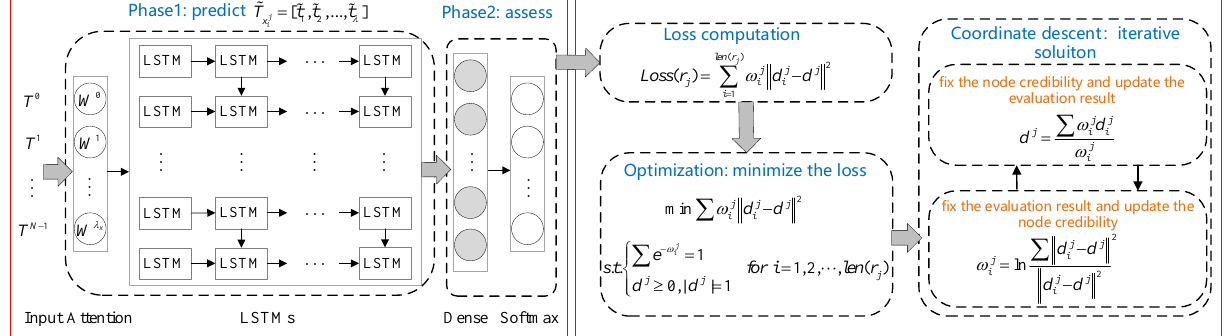
Figure 2. Evaluation procedure of a local region.